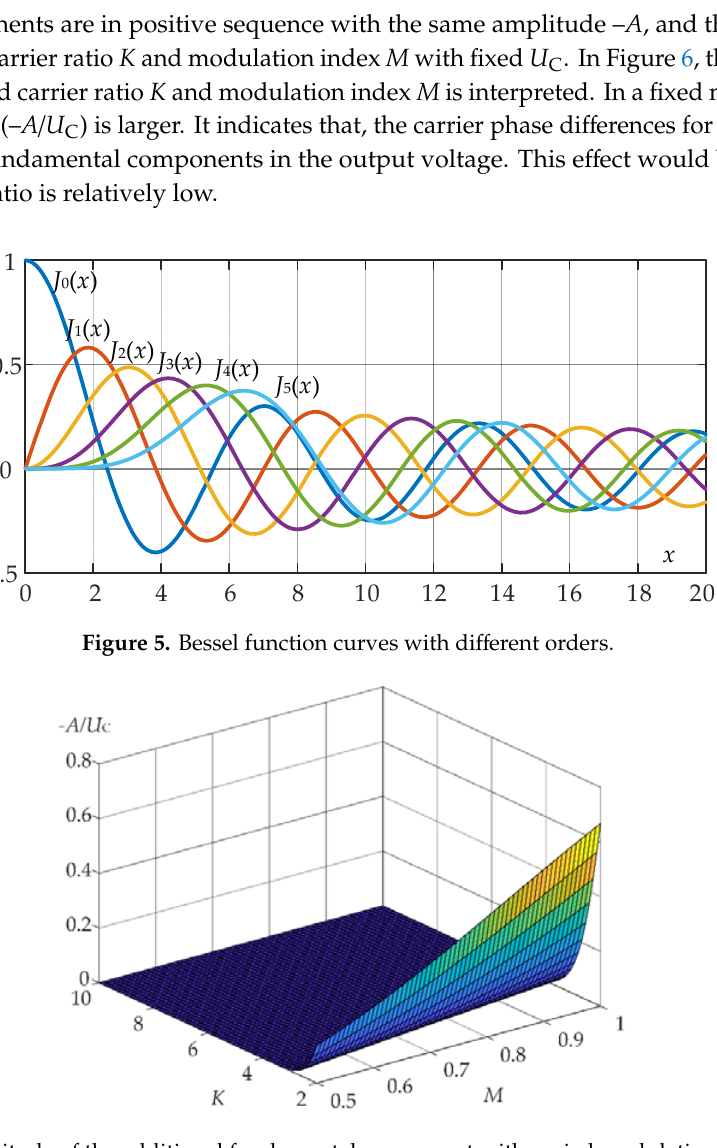
Figure 7. Vector graphs for modules considering additional fundamental components in output voltage.